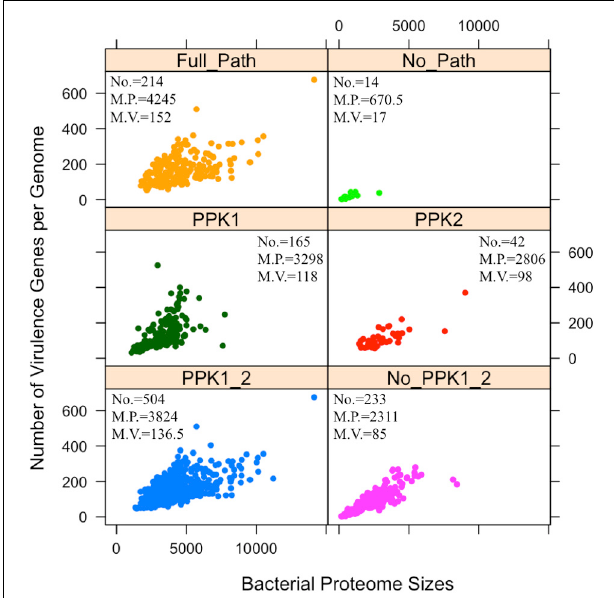
FIGURE 3 | Analysis of distribution patterns of bacterial virulence factors in terms of polyphosphate metabolism via scattered dot plots. Each sub-graph represents one of the six previously described polyP groups. For each group, numbers of bacterial species (No.), median number of proteome sizes (M.P.), and median number of virulence factors (M.V.) are presented. Y -axis indicates the number of virulence factors in a proteome. Each circled dot represents a single bacterium. Unpaired two-tailed Student’s t -test shows significant differences in two groups: PPK1_2/No_PPK1_2 and Full_Path/No_Path, in terms of the number of virulence factors ( p <